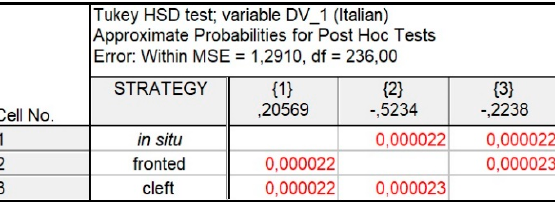
Figure 18. Operator mean results (Italian) .